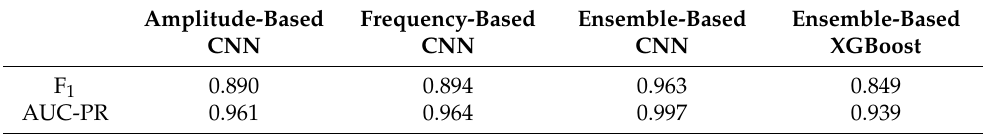
Table 3. Comparison of the prediction performance between the CNN- and XGBoost-based models when applied to the same unseen data. To evaluate the accuracy of the classifiers we use 10-fold cross- validation as well as F1 and AUC-PR metric scores that are recommended for the imbalanced data.